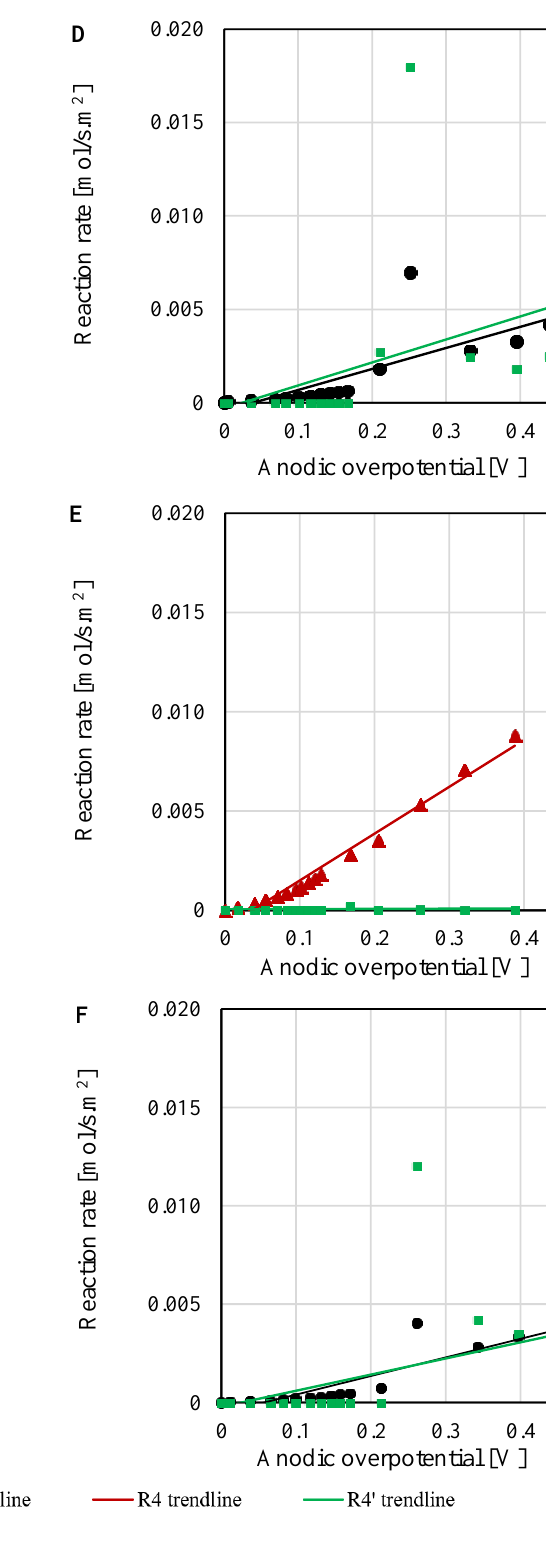
Figure 5. Reaction rates vs. anodic overpotential for different Pt–Sn catalysts. ( A ) Pt 9 Sn; ( B ) Pt 4 Sn; ( C ) Pt 3 Sn; ( D ) Pt 2 Sn; ( E ) PtSn 3 ; ( F ) ETEK.